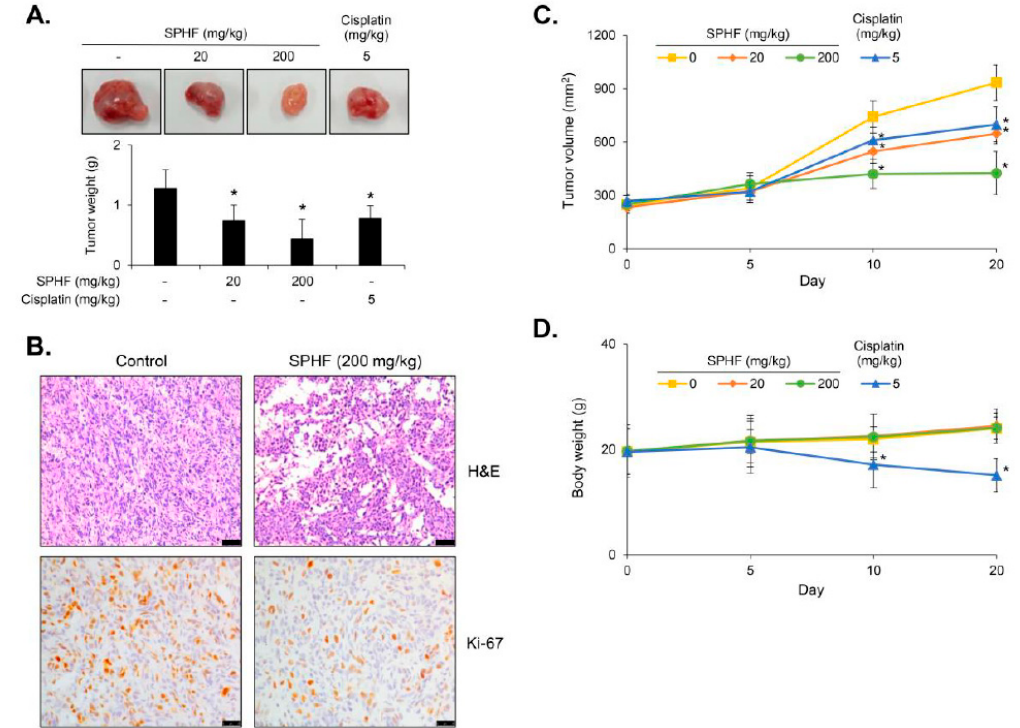
Figure 5. SPHF inhibited tumor growth in xenograft mice implanted with EJ cells. SPHF was orally administered at the indicated concentrations. Cisplatin (5 mg / kg) was also employed as a positive control to compare antitumor activity. ( A ) Weights and appearance of tumors isolated from EJ cell xenograft mice. ( B ) Tumor growth was evaluated by H&E and Ki-67 staining (scale bars = 50 µ m). ( C ) Tumor volumes obtained from xenograft mice were assessed daily. ( D ) Body weights were evaluated during SPHF administration (0, 20, and 200 mg / kg) and compared to cisplatin (5 mg / kg) treatment. Values are presented as the mean ± SD of three independent experiments; n = 5, * p < 0.05 relative to the non-treated